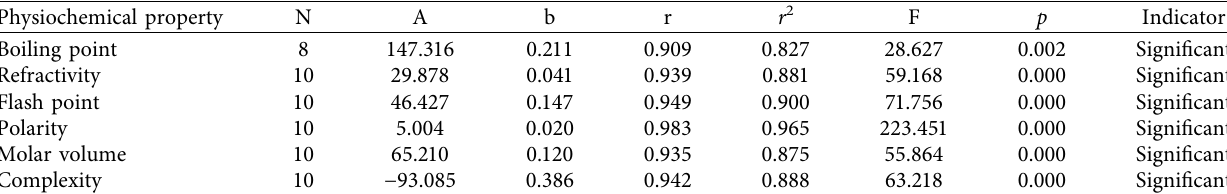
Table 11: Statistical parameters used in the QSPR model of H(G).